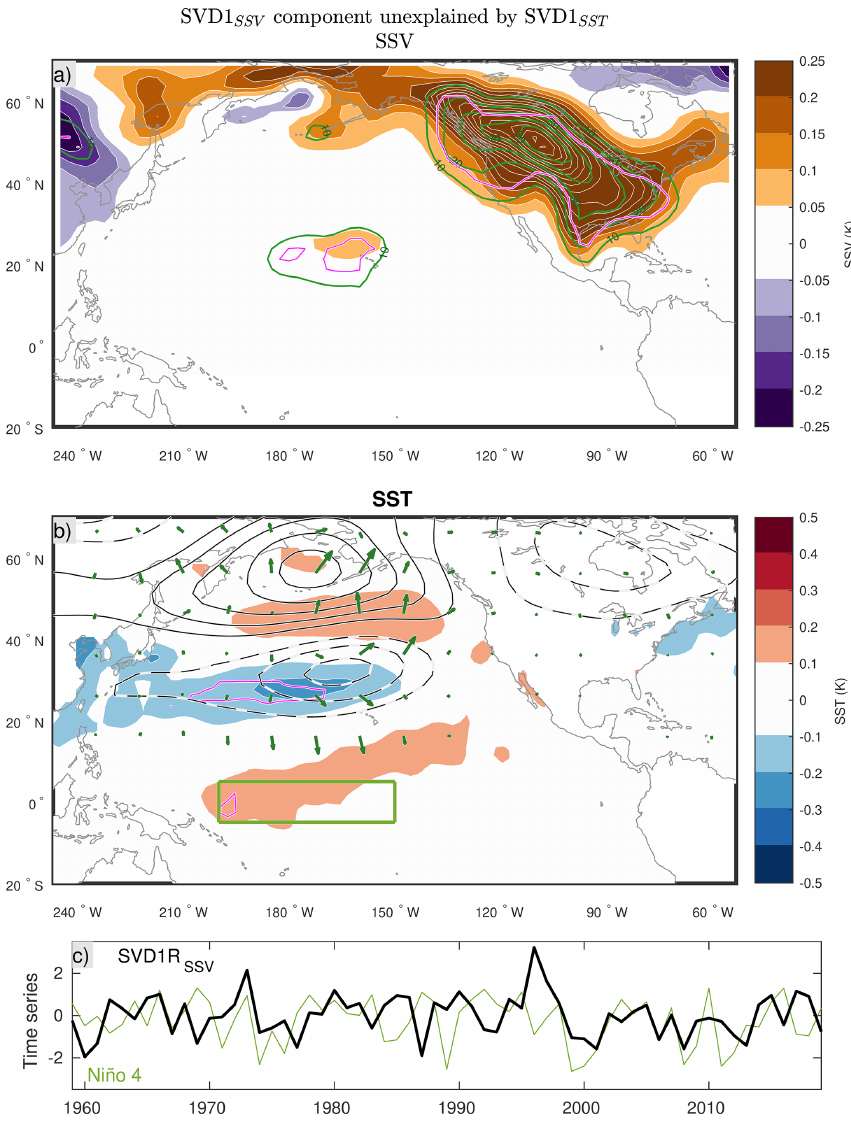
Figure 12. Subseasonal (10–60d) SAT variability (SSV) (a) and SST (b) are regressed on the component of SVD1 SSV that is not correlated with SVD1 SST (SVD1R SSV ). Regions that are statistically significant at the α FDR = 0 . 1 significance level are contoured in magenta. The green contours superimposed on panel (a) indicate the fraction of interannual SSV variability explained by this mode with 10% contour intervals (solid and dashed contours are used for positive and negative values, respectively; the 0 line is omitted). The regression of Z 500 (contours, 5m intervals with solid and dashed black contours for positive and negative anomalies) is also shown in panel (b) . The correspond- ing wave-activity fluxes (Takaya and Nakamura, 2001) are shown with green arrows. A distance of 1 ◦ corresponds to a flux of 0.125m 2 s − 2 . The SVD1R SSV time series, as well as the Niño 4 index, are shown in panel (c) and the region used to compute this index is illustrated over the SST pattern in panel (b)